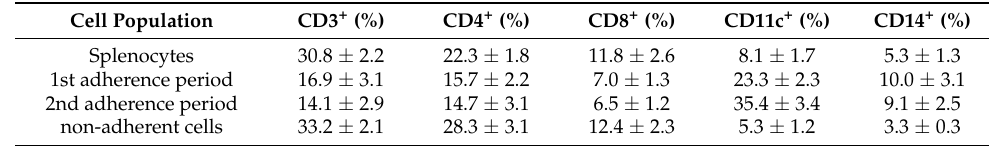
Table 1. Characterization of cell populations enriched by a sequential adherence method. Dif- ferentiation markers of cell populations: CD3 + -T-cells, CD4 + -helper T-cells (Th), CD8 + -cytotoxic T-lymphocytes (CTLs), CD11c + -DCs, monocytes, granulocytes, CD14 + -macrophages,